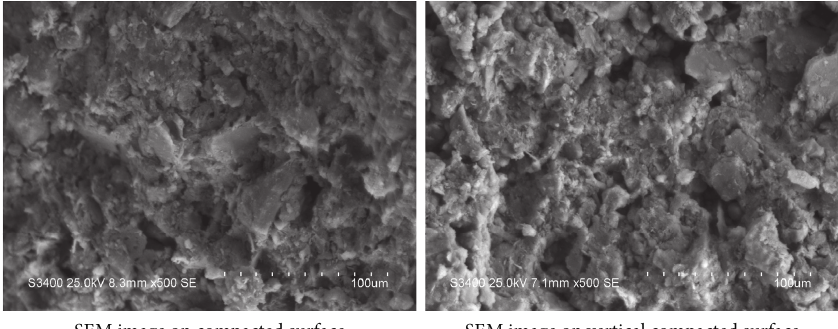
� 1.70g/cm 3 . (b) ρ d